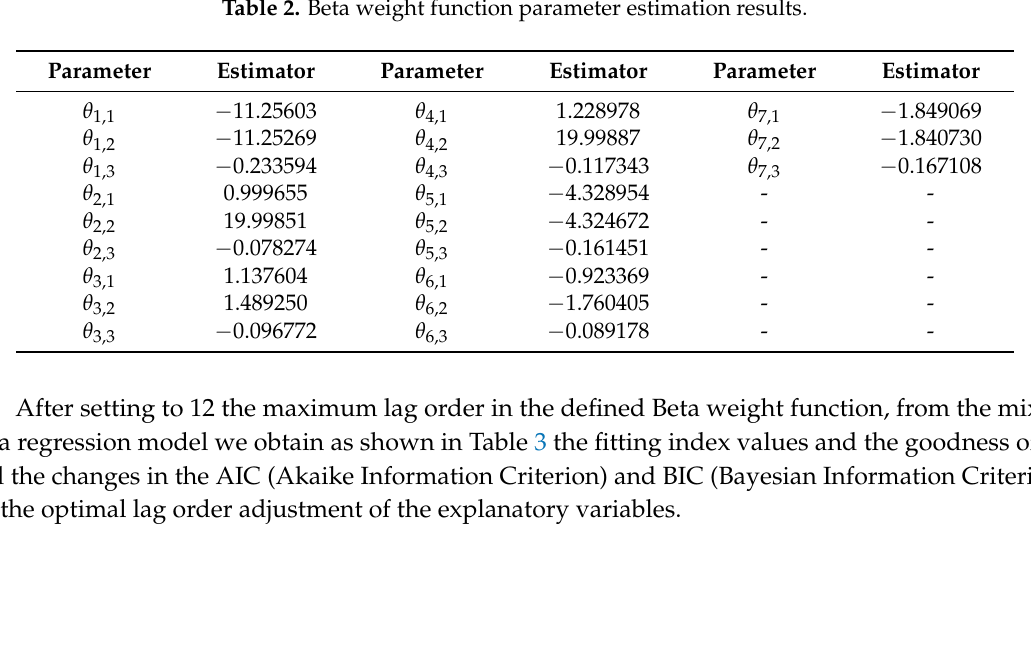
Table 2. Beta weight function parameter estimation